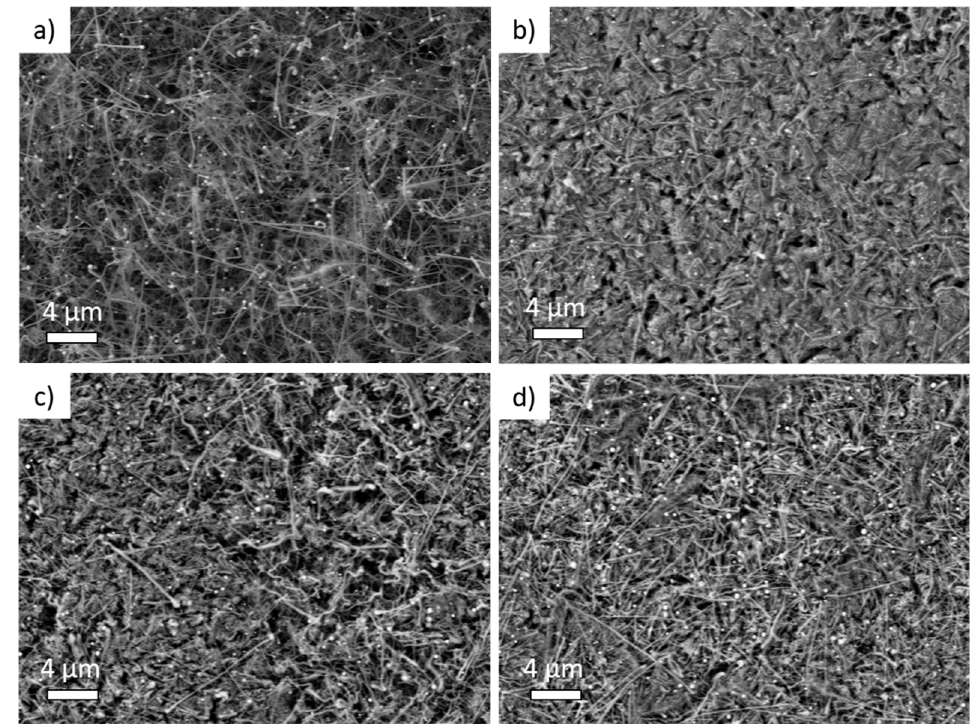
Figure 2. Scanning Electron Microscopy medium magnification (5000 X) images of ( a ) pristine Si NW anode, ( b ) Si NW anode cycled with 1M LiPF 6 electrolyte, ( c ) added with 3% of fluoroethylene carbonate (FEC) or ( d ) added with 3% of vinylene carbonate (VC) additive.